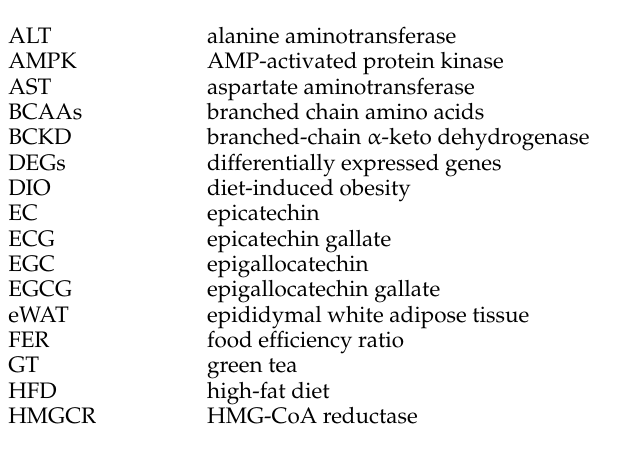
Table S1: Primer sequences used for RT-qPCR, Figure S1: Validation of RNA-seq data by